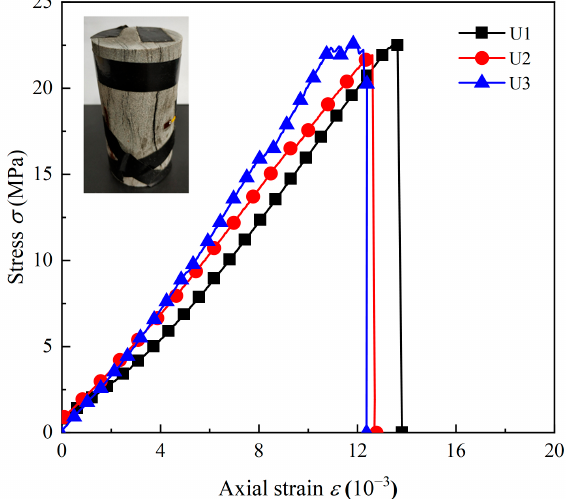
Figure 6. Uniaxial compression stress–strain curves.